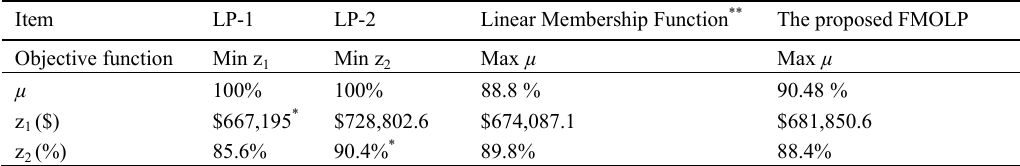
Table 7. Comparative analysis